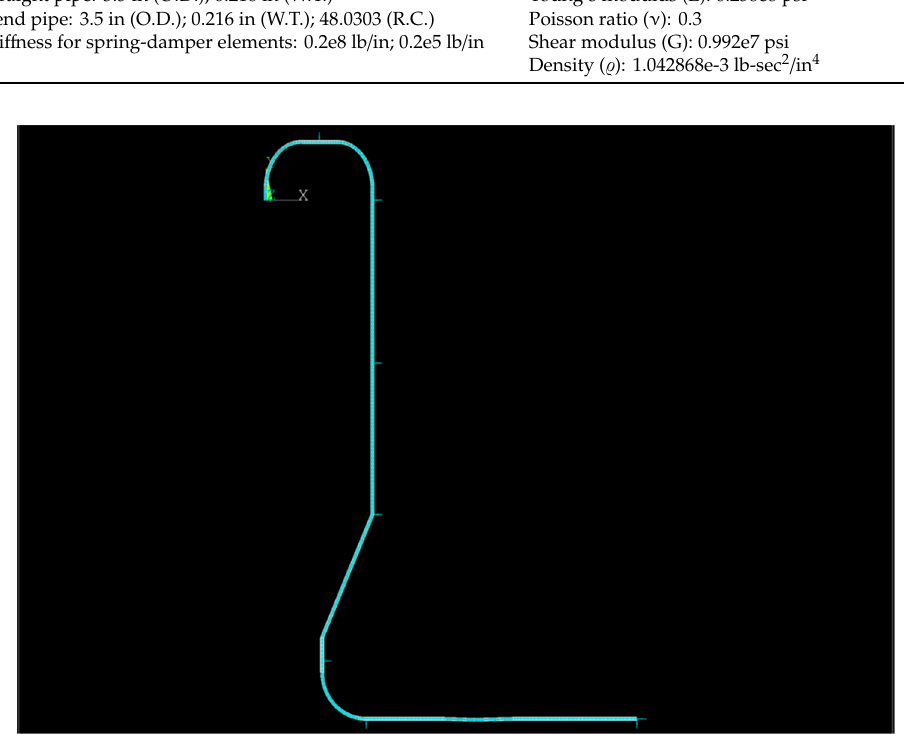
Figure 1. NUREG/CR-1677 Benchmark piping system layout and numerical model Figure 1. NUREG / CR-1677 Benchmark piping system layout and numerical